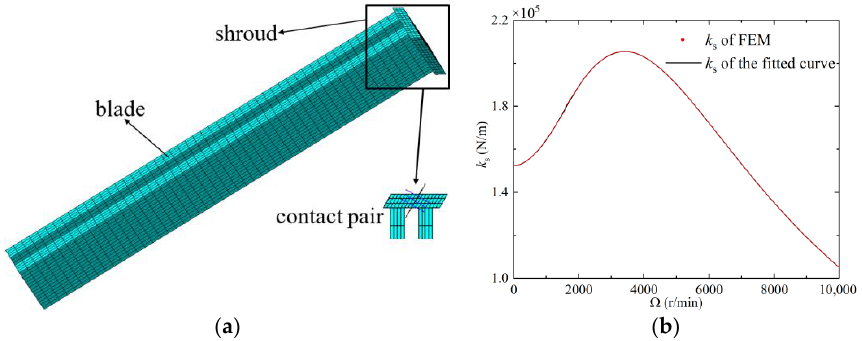
Figure 3. Calculation and fitting of normal contact stiffness. ( a ) Finite element model and ( b ) Fitted curve of the contact stiffness.